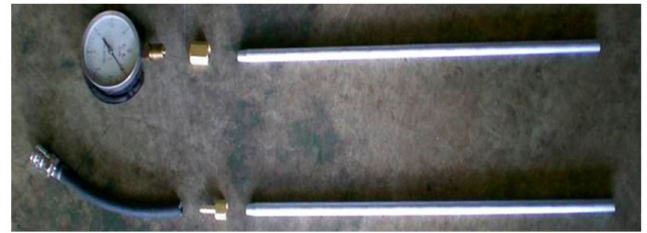
Figure 13. New pressure test